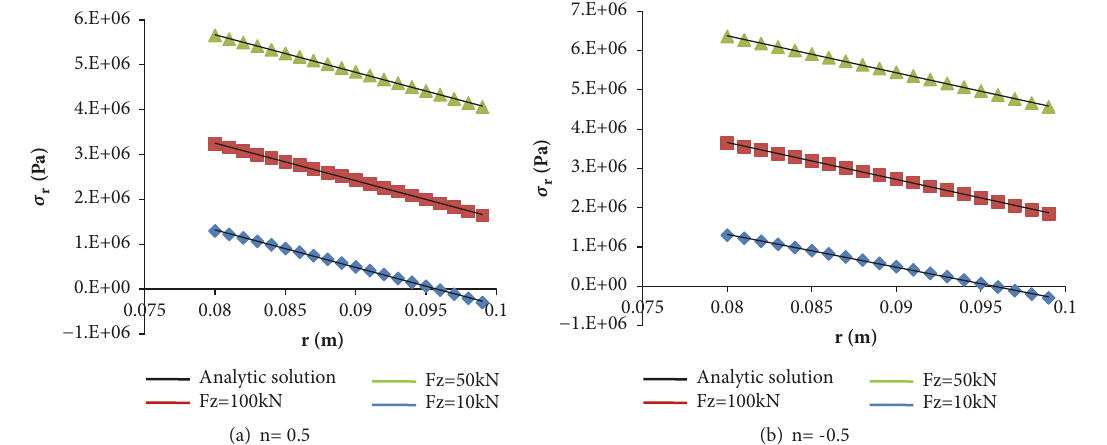
Fz=10kNFz=50kN Fz=100kNAnalytic solution